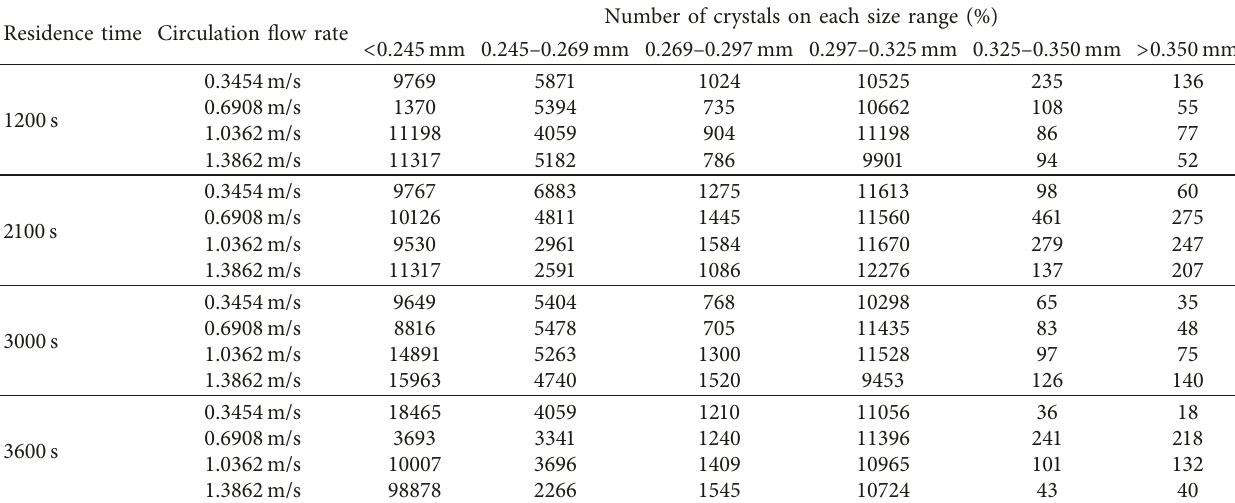
Figure 10: SEM images of crystal before and after breakage: (a) the seed crystals; (b) 2100 s; (c) 3000s; (d) 3600s. Table 2: Crystal breakage of different operation